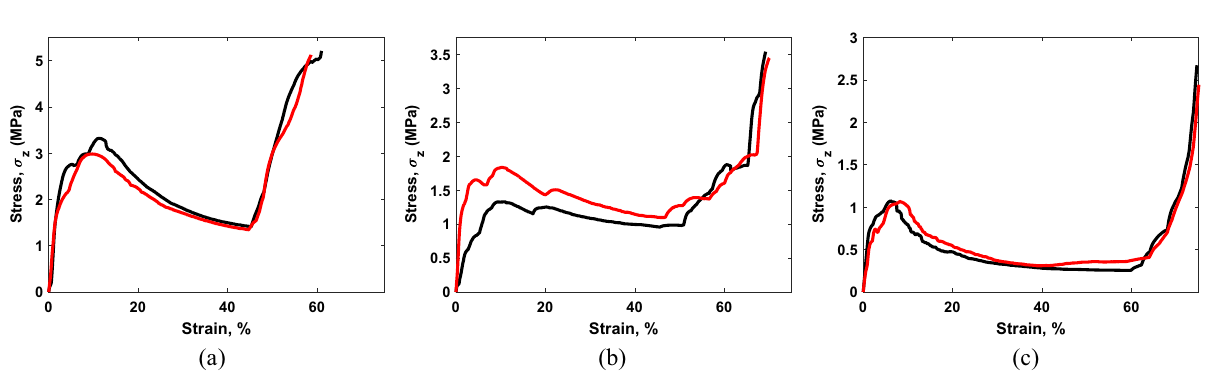
Figure 8. Stress vs lattice strain curves of 2 × 2 × 1 cell lattice structures for Z -axis loading: ( a ) 8 mm cell, relative density = 0.086; ( b ) 10 mm cell, relative density = 0.064; and ( c ) 12 mm cell, relative density = 0.05.